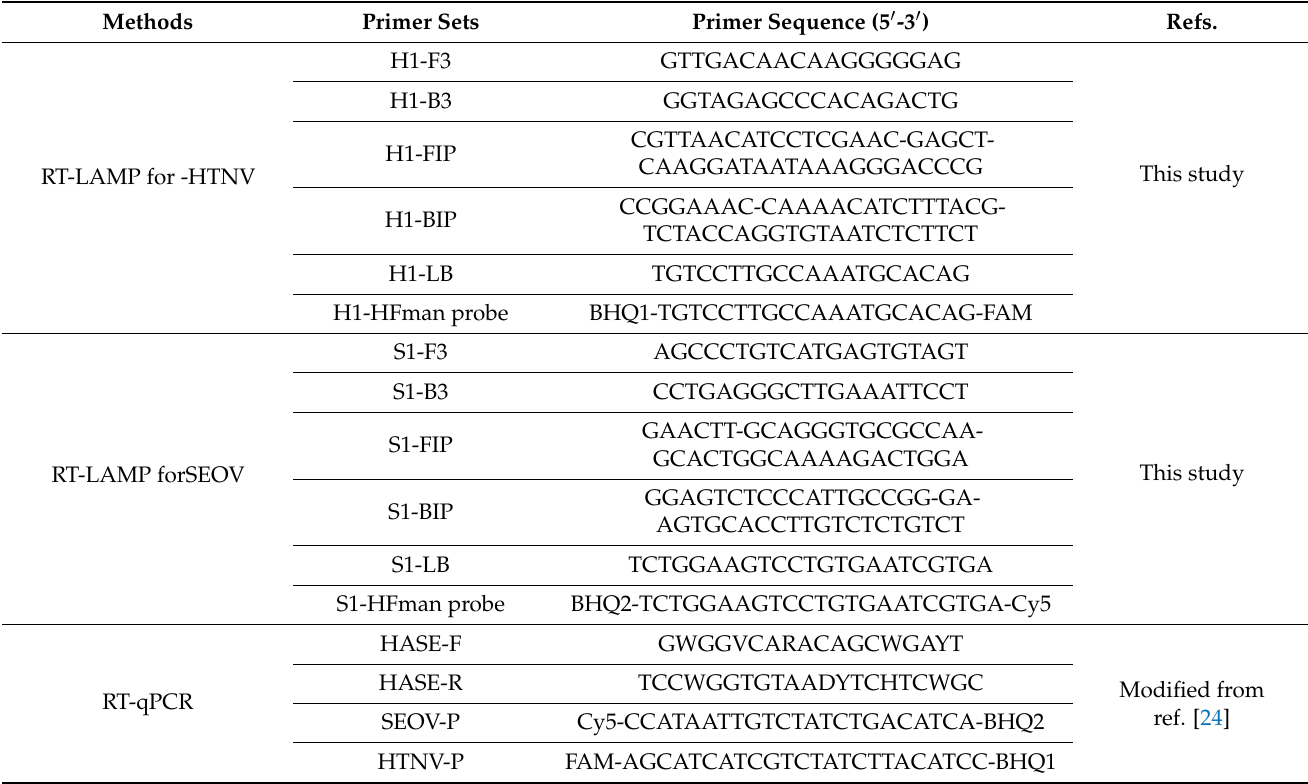
Table 1. Primers and probes used in this